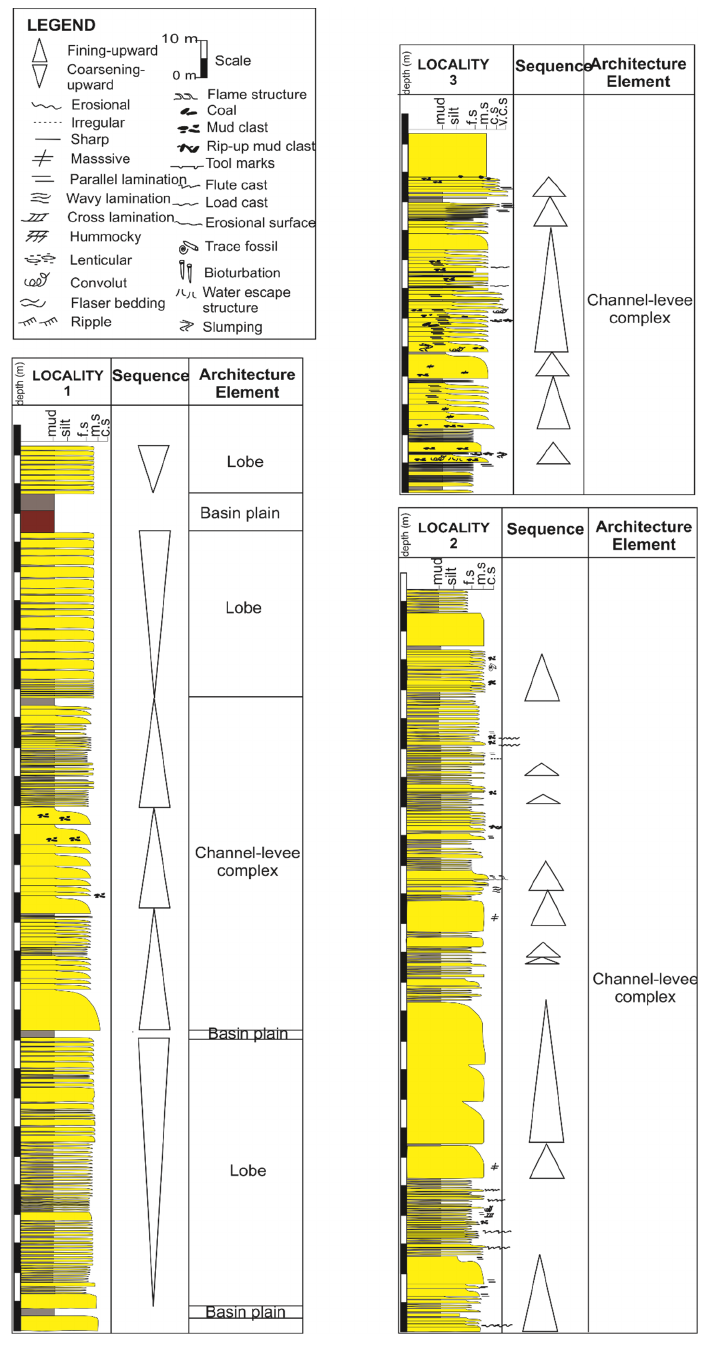
Figure 6. Sedimentary log of L1 to L3, north region of the northwest Crocker Formation.